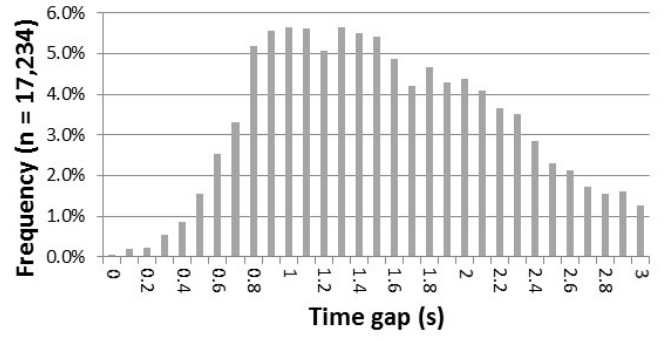
Figure 5. Distribution of the time